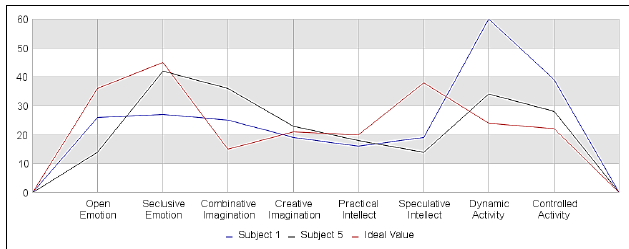
Fig. 4. Comparison graph of the character values of Subject 1 and Subject 5 against the ideal